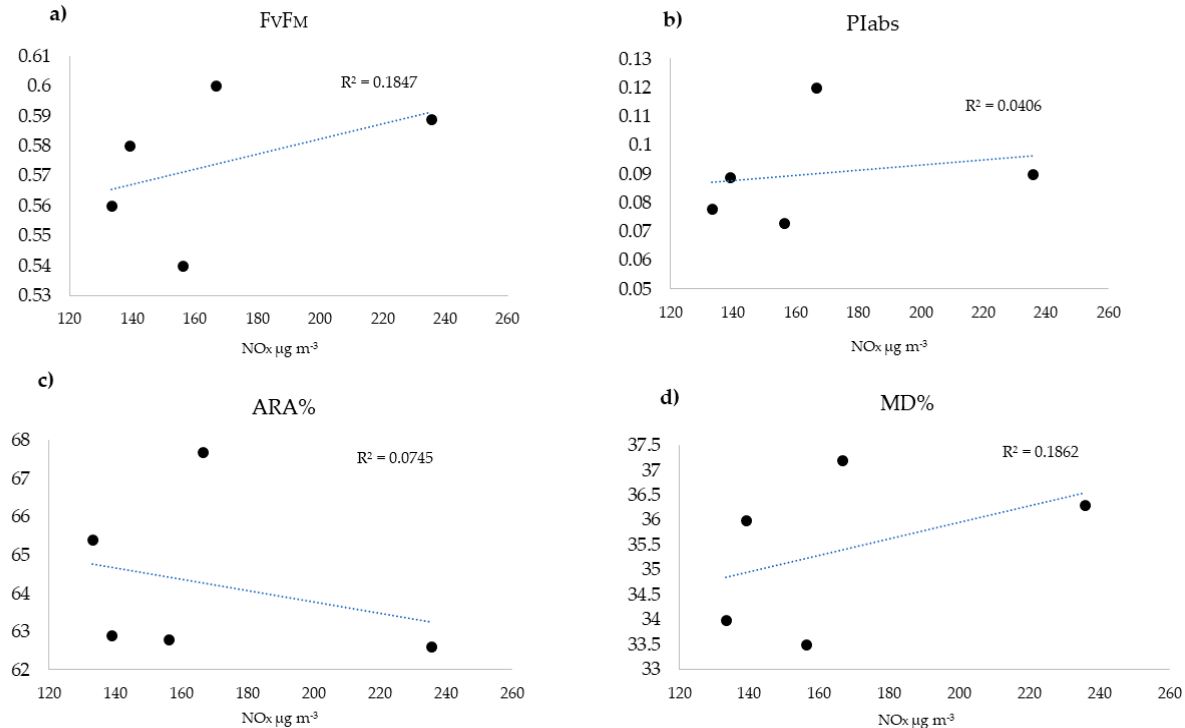
Figure 9. Linear relation between NO x and physiological parameters measured in the surrounding of the monitoring stations. No significant relations emerged. ( a ) Fv/F M , ( b ) PI ABS , ( c ) MD%, and ( d ) ARA%.